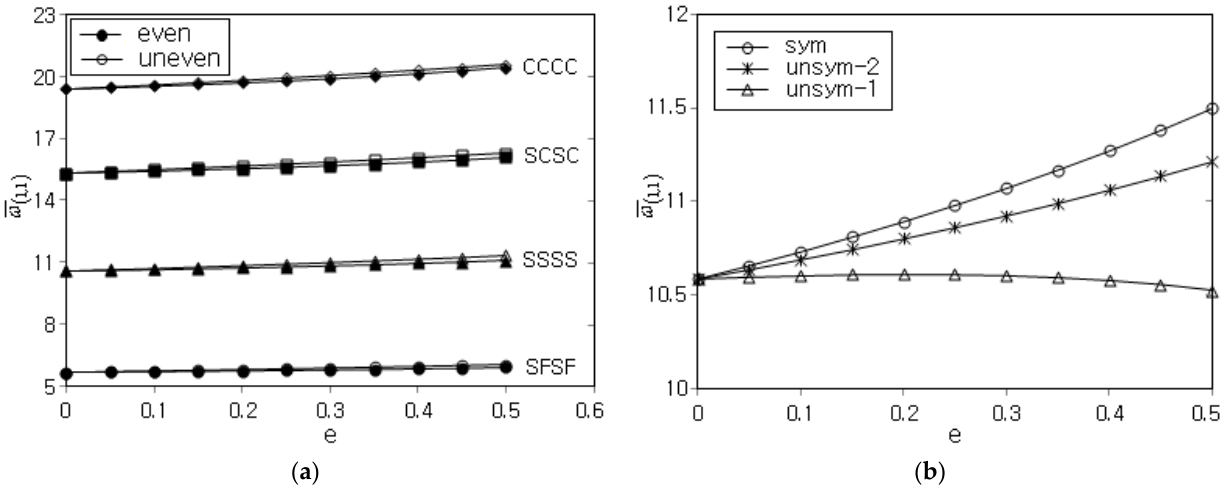
Figure 8. Dependence of the calibrated fundamental frequency on the porosity parameter ( a / h = 20, n = 0.3 ) : ( a ) for different boundary conditions, ( b ) for